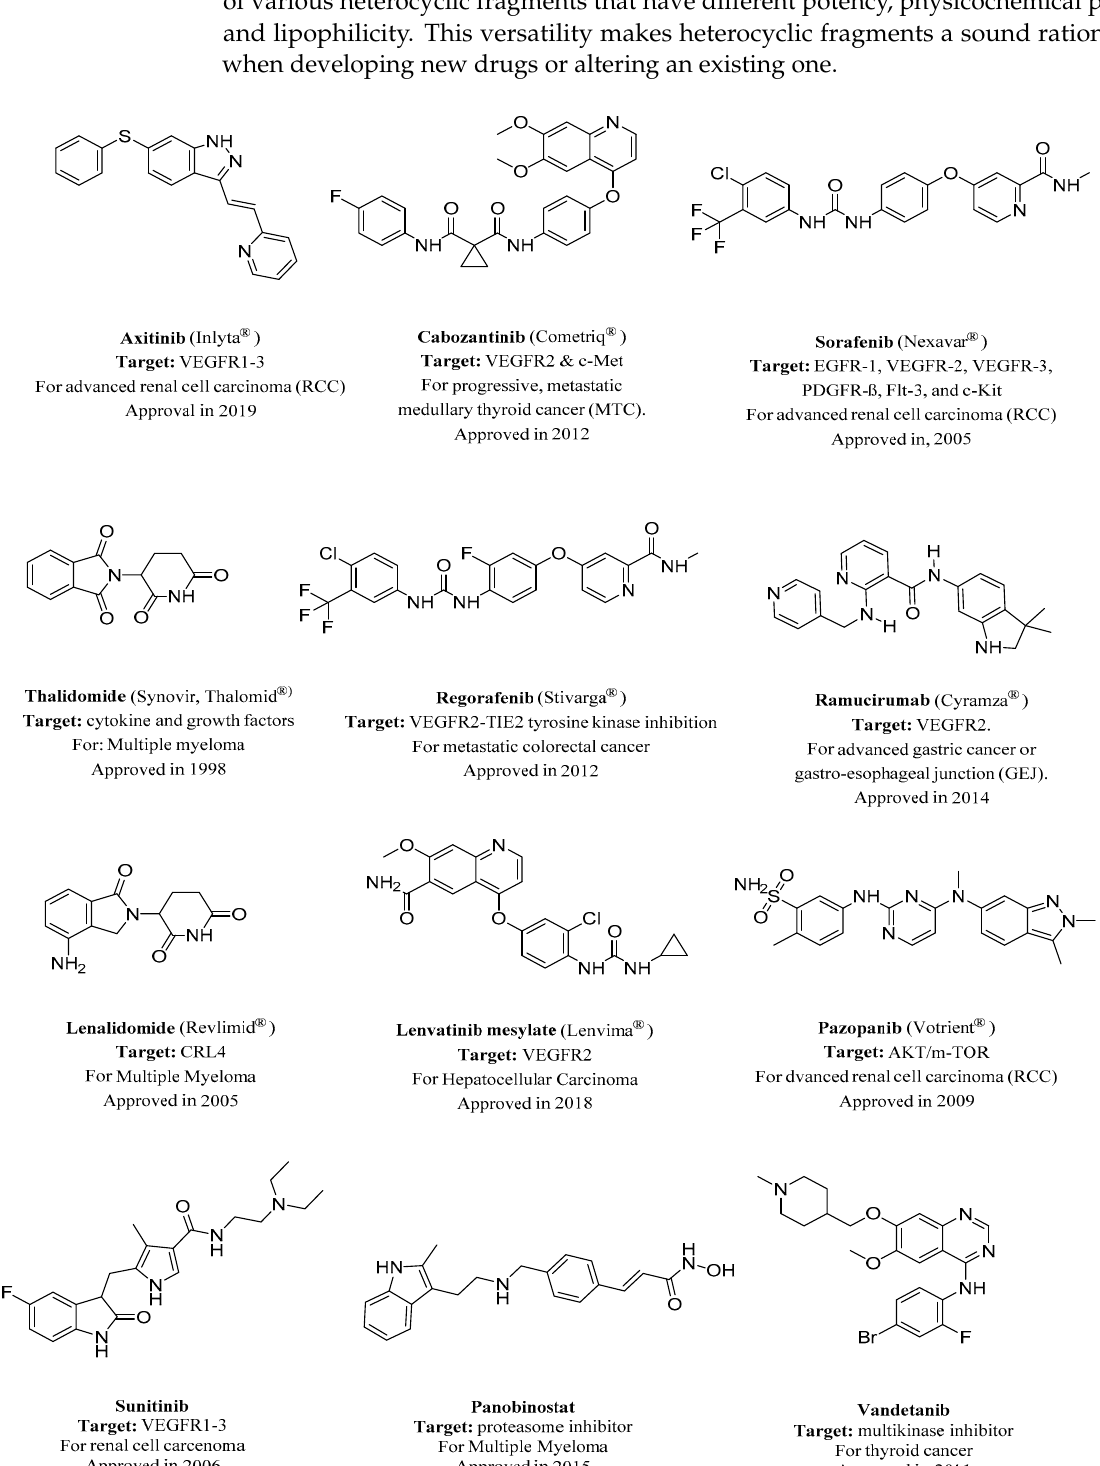
factor receptor.